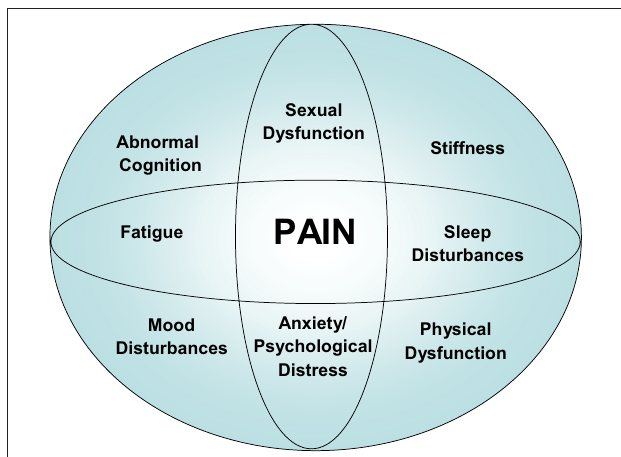
Figure 1 | Fibromyalgia